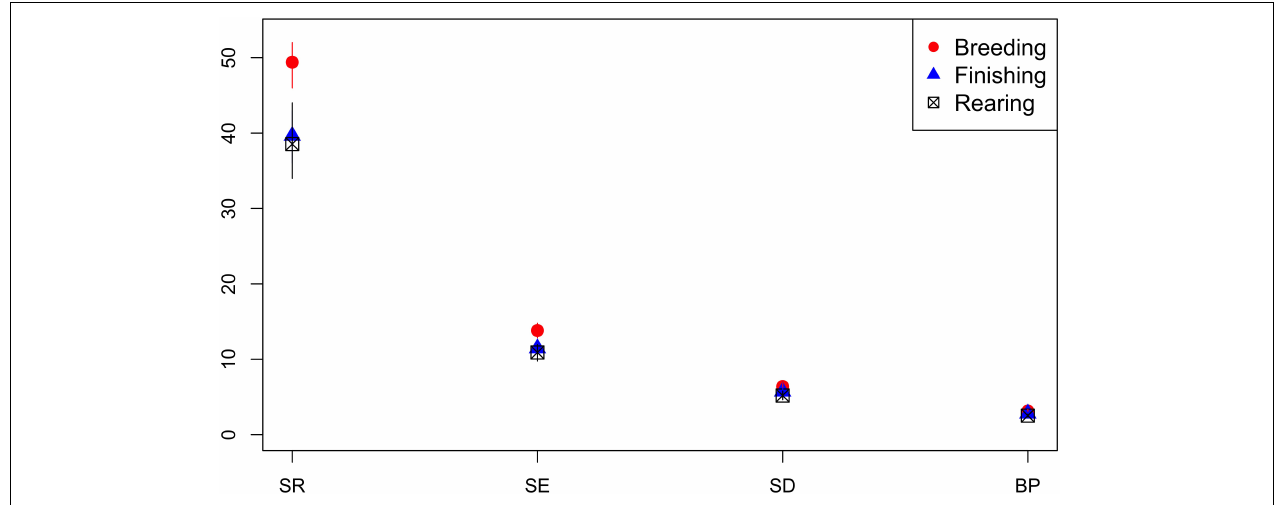
FIGURE 8 | Observed ecological diversities of phenotypic antimicrobial resistance profiles of S. Typhimurium isolates from breeder, finisher, and rearer pigs.